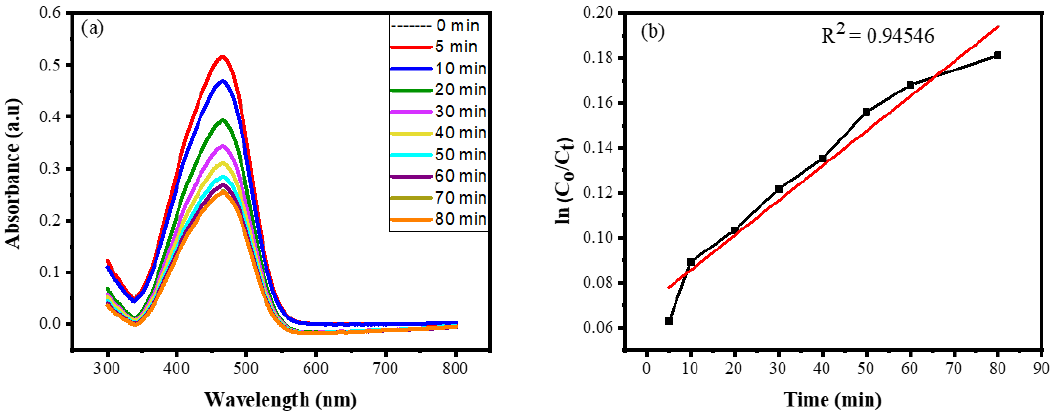
Figure 6. ( a ) Adsorption of MB dye in the presence of Mn 3 O 4 -based nanomaterials, and ( b ) kinetic study of the adsorption process in the dark .